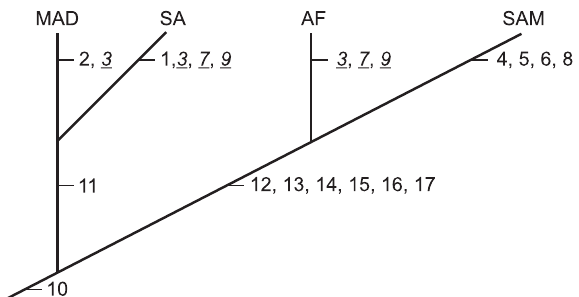
Figure 2. Cladogram presenting the general pattern of distribu- tion among cuckoos subfamilies and Gondwanaland areas ( sensu C RACRAFT 2001), except for Australia and Antarctic. (AF) Africa, (MAD) Madagascar, (SA) Southeast Asia, (SAM) South America, (1) Carpococcyx , (2) Coua , (3) Centropus , (4) Neomorphinae, (5) Crotophaginae, (6) Taperinae, (7) Phaenicophaeinae, (8) Saurotherinae, (9) Cuculinae, (10-17) arbitrary numbers showing the relationships among taxa. The numbers in italic and under- lined represent the homoplasies.